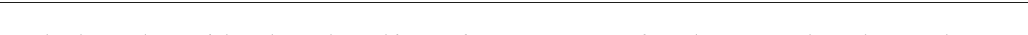
Fig. 7 Molecular regulation of the subcapsular proliferative foci. a Enumeration of population 1, 2 and 3 in the secondary response following inducible deletion of MHCII. Data is representative of three experiments with n = 6 each group. Comparison between groups utilised one-tailed unpaired Student ’ s t - test. b Enumeration of population 1, 2 and 3 in the secondary response following ibrutinib treatment after reactivation of MBCs. Data are representative of 2 experiments with n = 5 each group. Comparison between groups utilised one-tailed unpaired Student ’ s t -test. Box plots show centre line as median, box limits as upper and lower quartiles, whiskers as minimum to maximum values. c Representative immunohistochemical analysis of draining cervical lymph node from a patient with head and neck cancer showing CD169 (brown) and CD138 (red) expression. Hematoxylin nuclear counterstain (blue). Scale bar = 100 μ